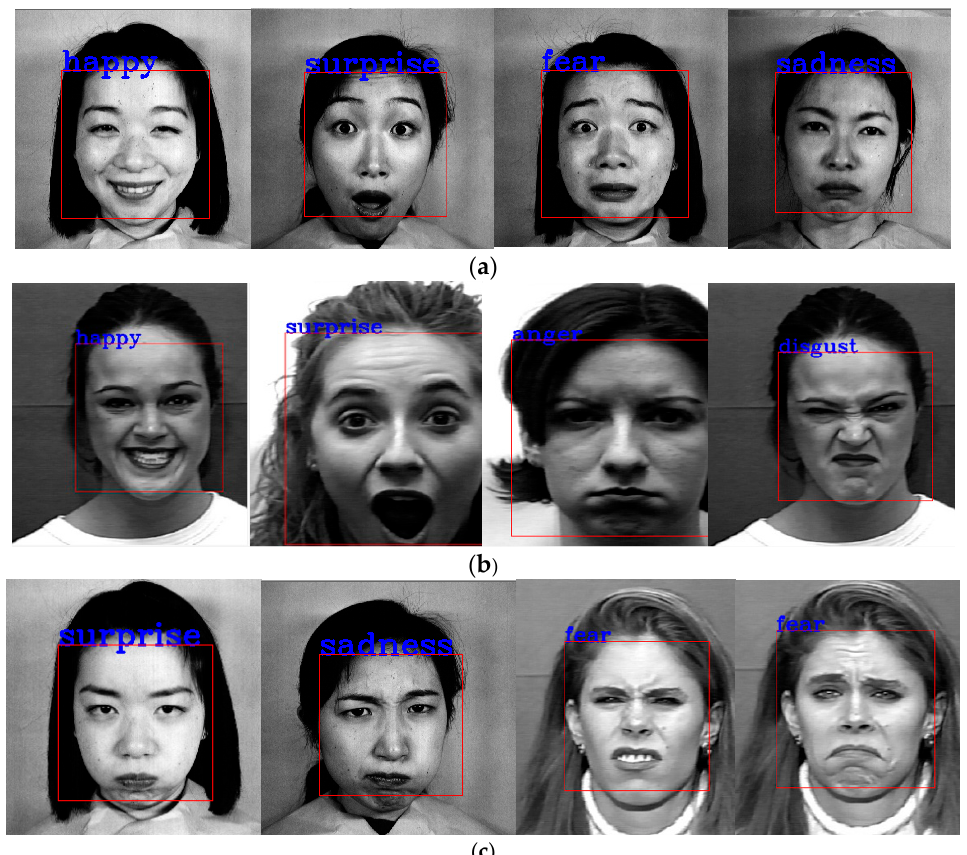
Figure 10. Facial expressions recognition results. ( a ) Correctly-classified expression on the JAFEE database; ( b ) correctly-classified expression on the Cohn–Kanade database; ( c ) misclassified expressions; the true expressions are angry, angry, disgust and sadness in turn.